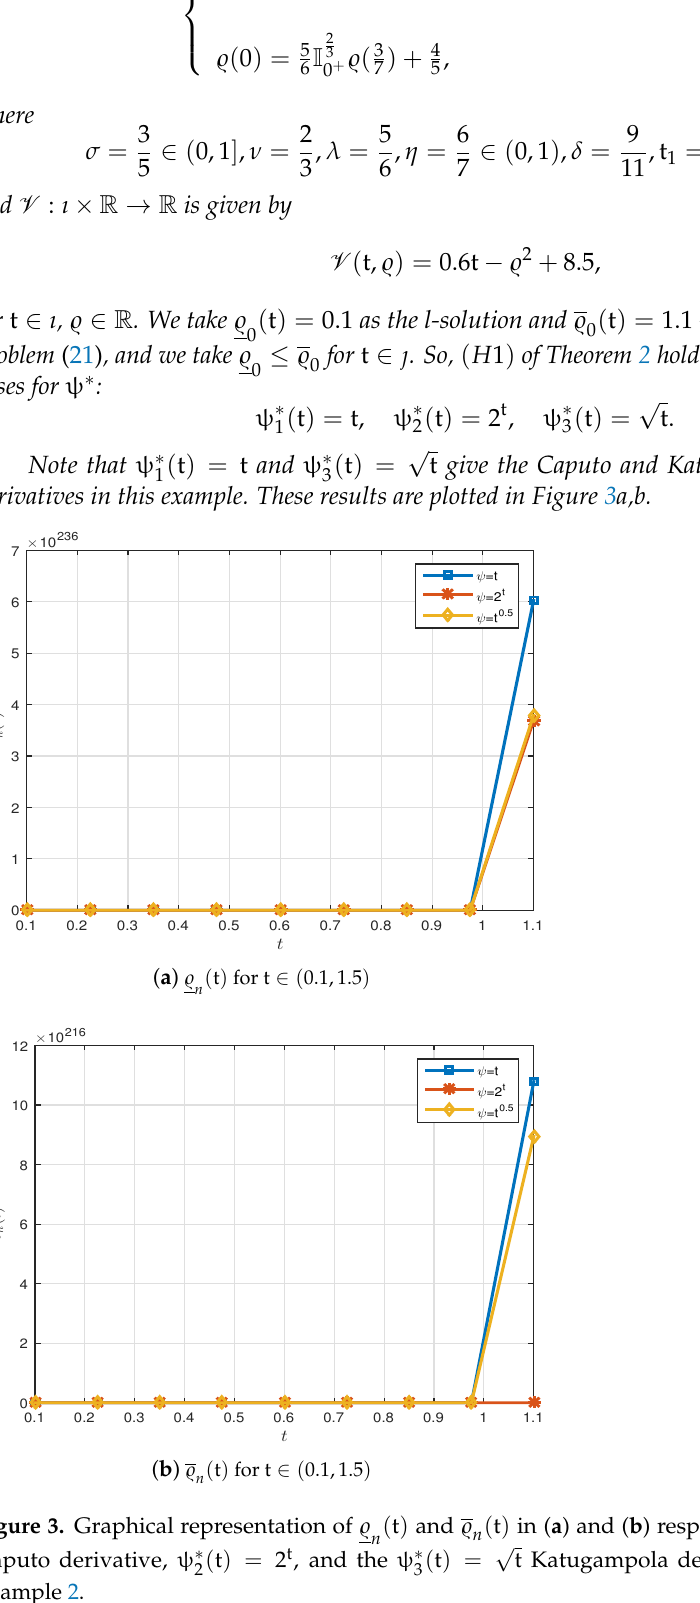
Figure 3. Graphical representation of (cid:36) Caputo derivative, ψ ∗ Example